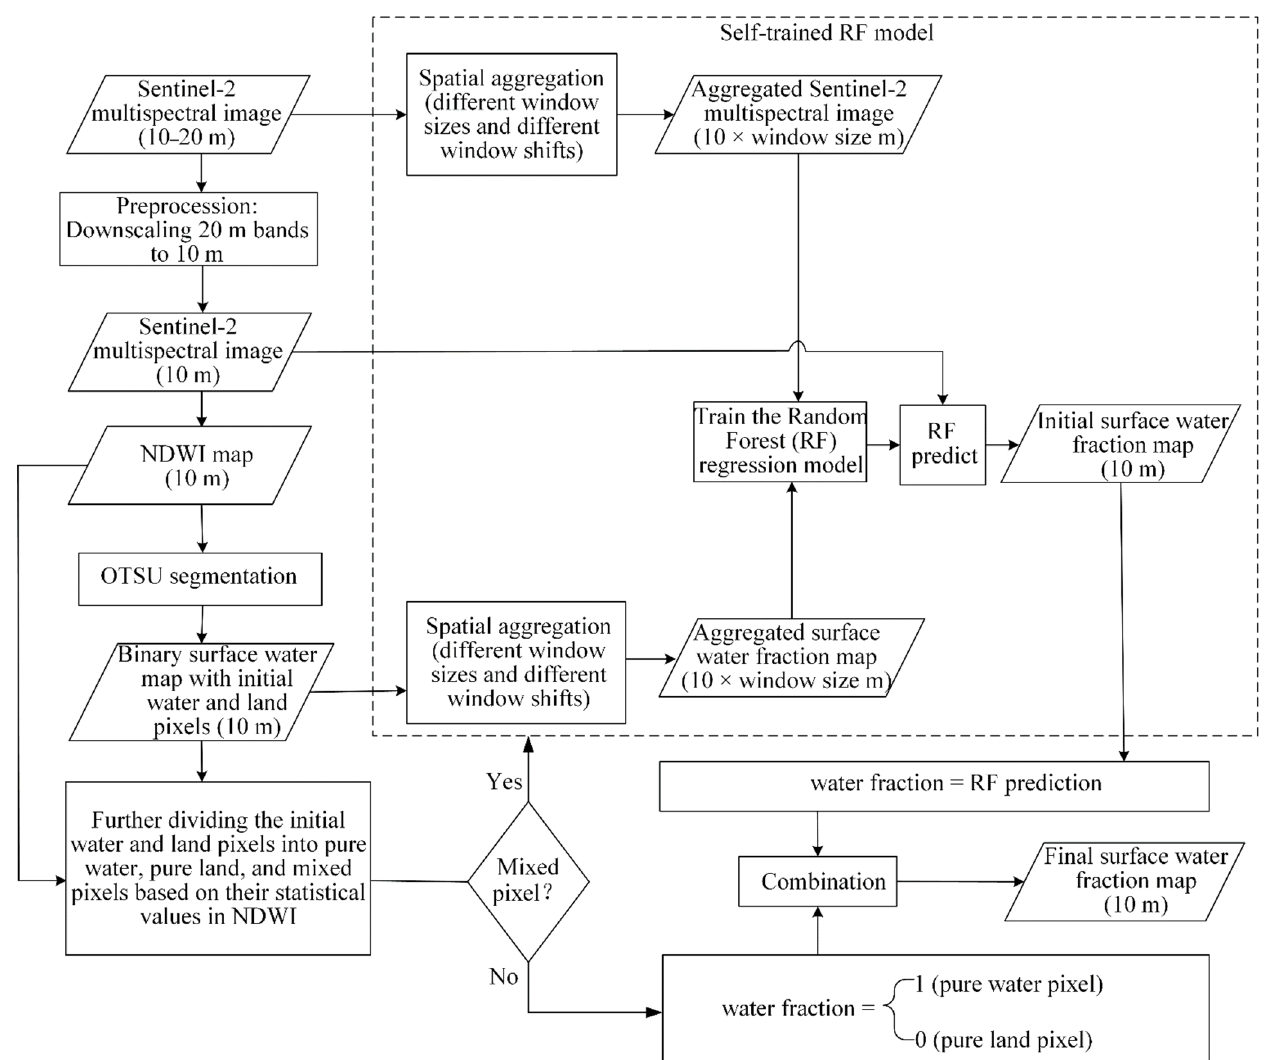
Figure 3. Flowchart of the proposed automated and hierarchical surface water fraction mapping (AHSWFM) method.